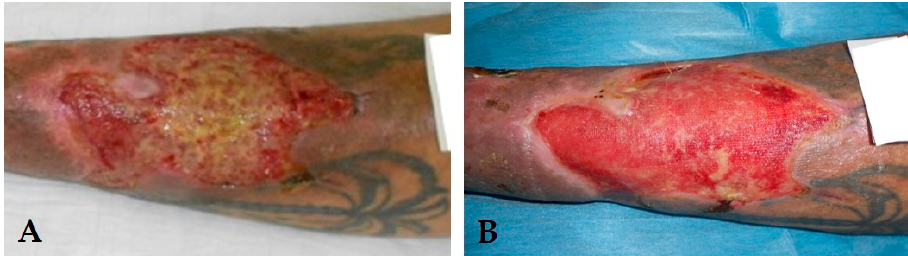
Figure 1. Clinical aspects of different wound healing phases in the same patient. In ( A ) a representative example of venous leg ulcer “blocked” in the inflammatory state of wound healing (inflammatory ulcer); In ( B ), the same patient underwent to conservative or surgical therapeutic procedures which turned the ulcer in granulation state (granulating ulcers).